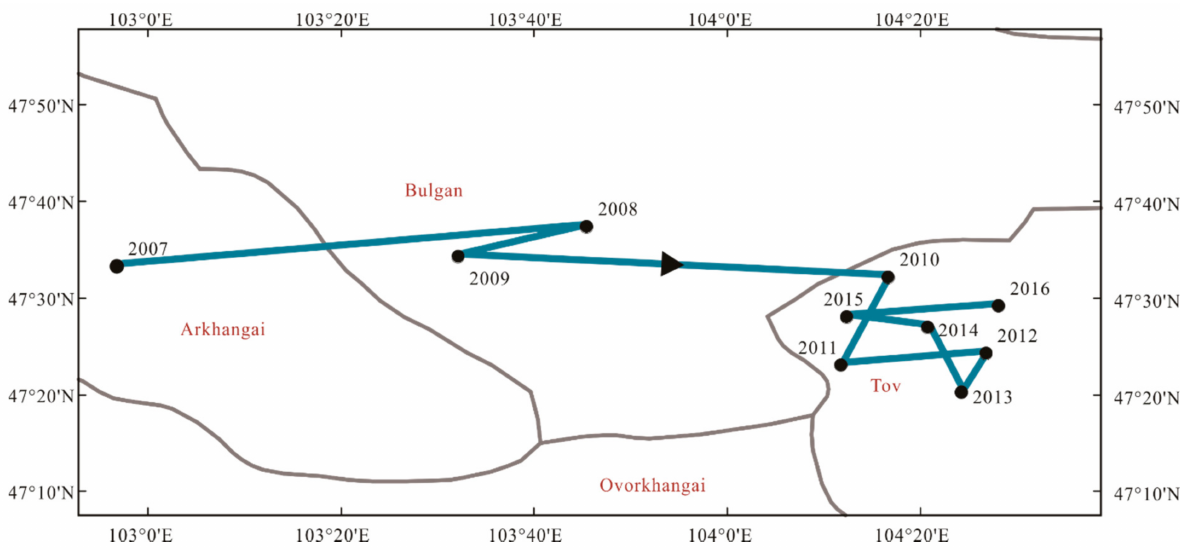
Figure 5. The evolution of Mongolian eco-efficiency center of gravity from 2007 to